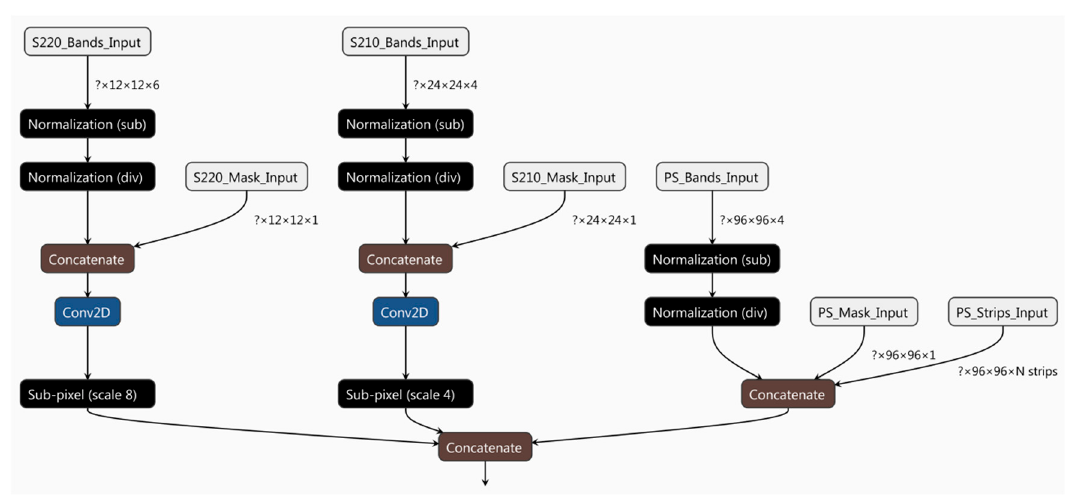
Figure 4. Neural network architecture: data transformation step of the two super-resolution neural networks. PS, PlanetScope; S210, Sentinel-2 10-m data; S220, Sentinel-2 20-m data. See Table 2 for patch sizes and resolutions of input and output data.